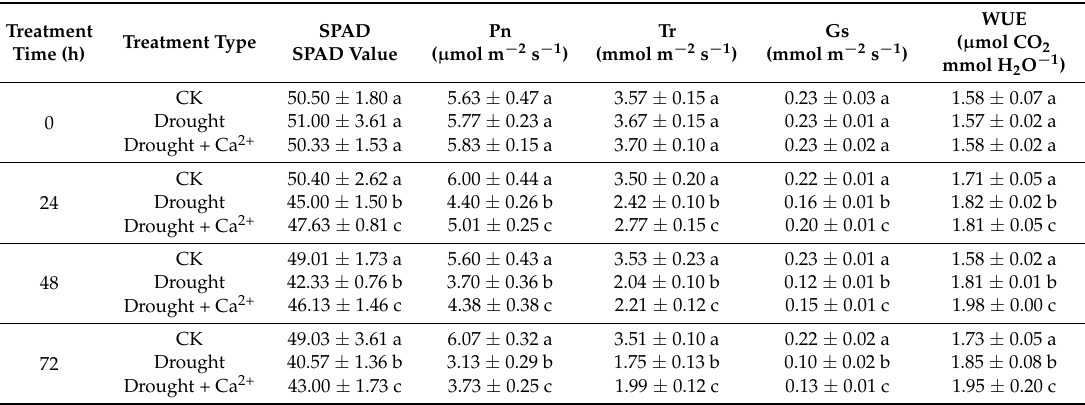
Table 1. Photosynthetic parameters in C. glauca leaves under drought stress and amended with Ca 2+ . Treatment Time